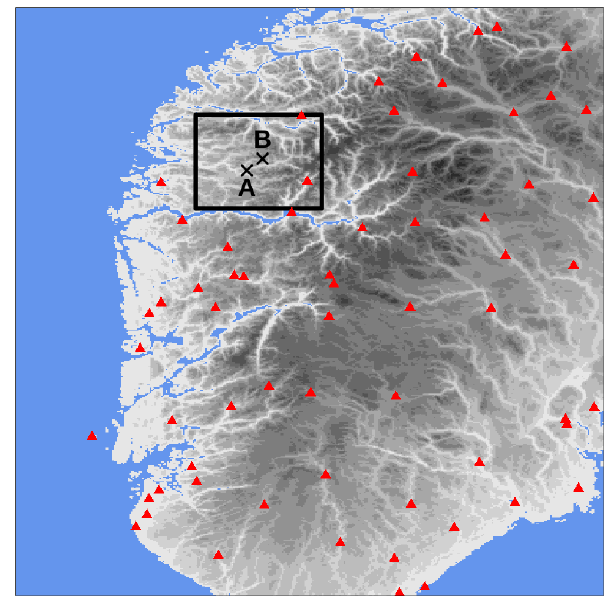
Figure 7. South Norway domain used in the simulations of Sects. 3.2 and 3.3. The red triangles mark station locations used for cross-validation in Sect. 3.3. The gray shading indicates the altitude (from lighter gray at 0m to darker gray at approximately 2400m above mean sea level – a.m.s.l.). The blue shading indicates the sea. The black box delimits the Sogn og Fjordane domain shown in Figs. 11 and 12; the crosses mark the two points, A and B, re- ferred to in the following.